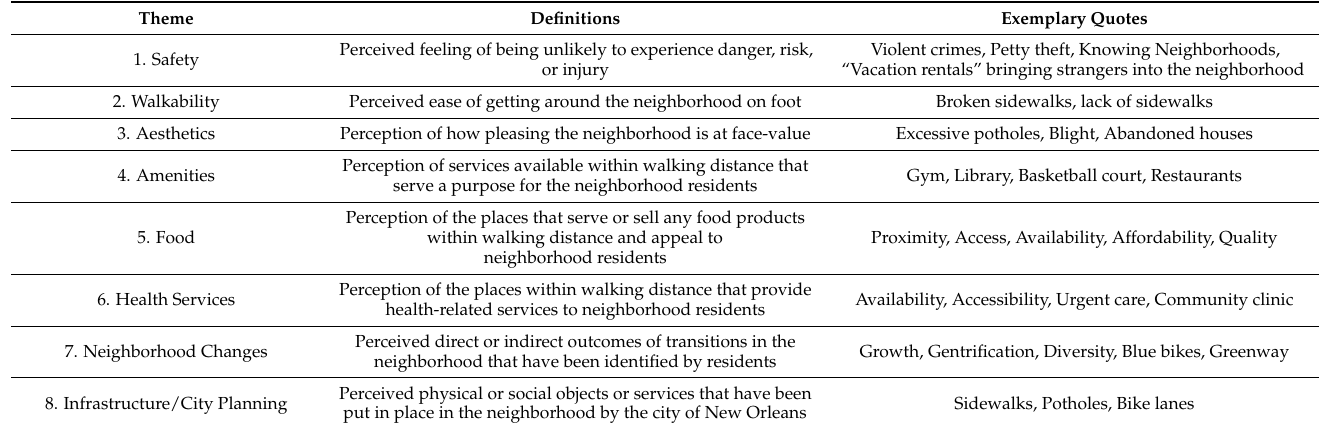
Table 2. Major Themes Identified in Citizen Scientists’ Photos and Audio